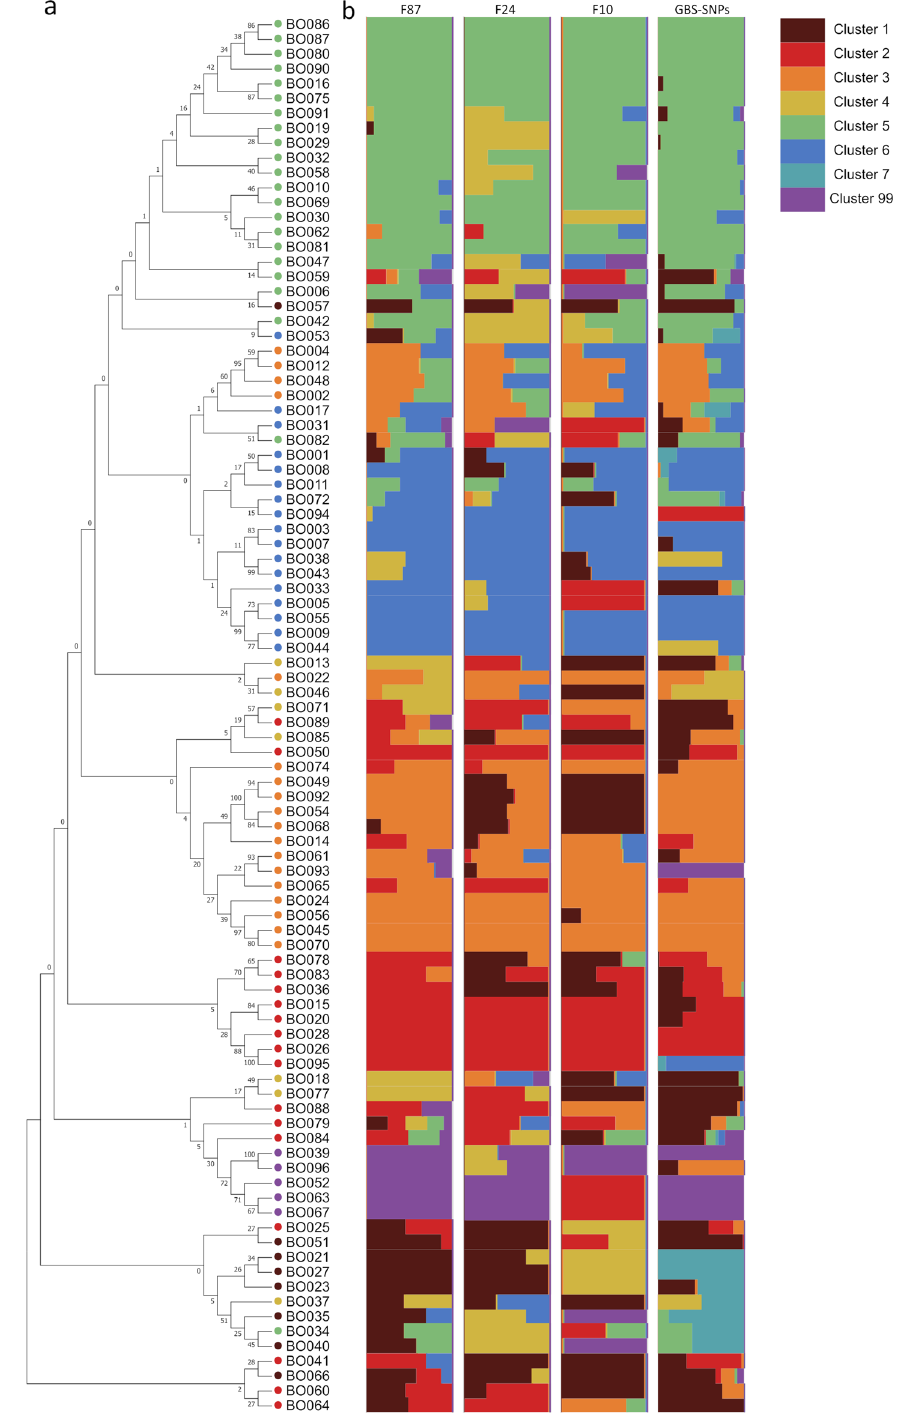
Figure 3. Phylogenetic tree and population structure analysis of 94 cabbage varieties. ( a ) Phylogenetic tree constructed using the neighbour-joining method from genotypes of 87 core markers. Coloured dots indicate consensus of clusters of F87, F24 and F10. ( b ) Q plots for the respective F87, F24, F10, and GBS-SNPs. Each cluster colour indicates a proportion of the